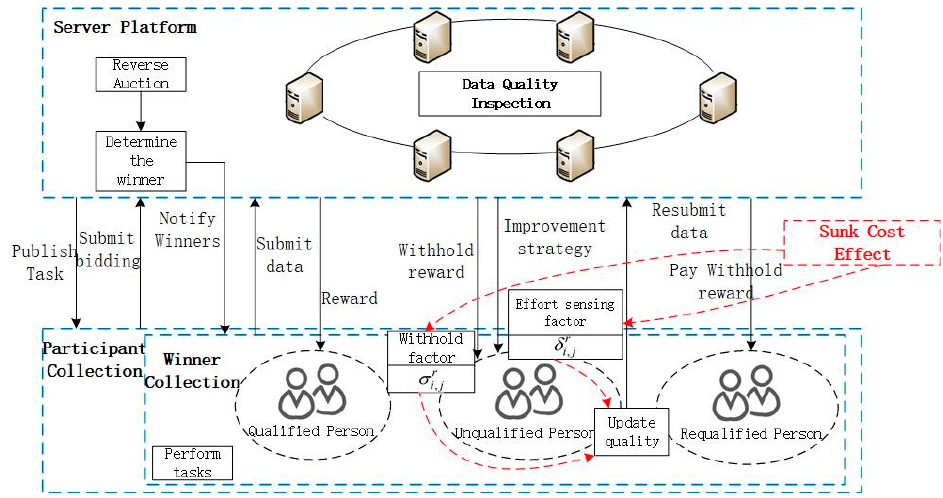
Figure 1. IMBSC System Model.